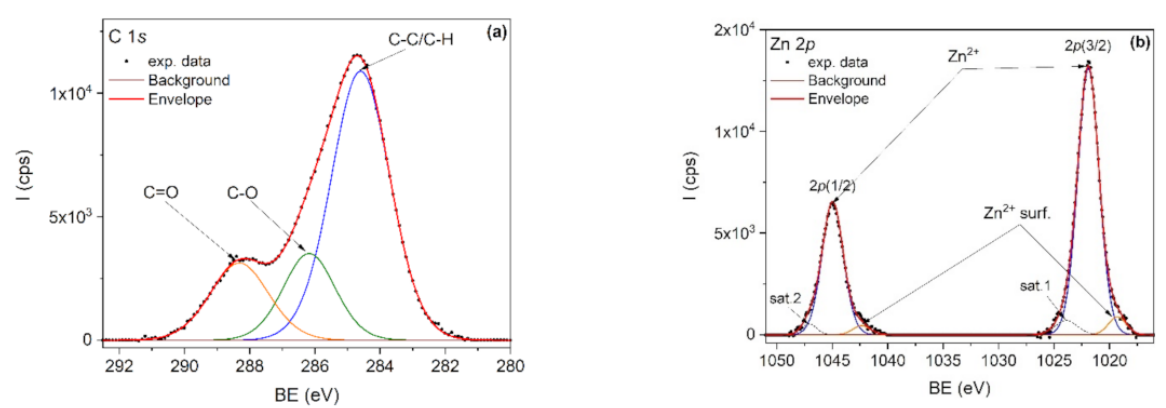
Figure 8. XPS spectra of PLA/PHBV/ZnO:Fe0.3 sample: ( a ) C 1s and ( b ) Zn